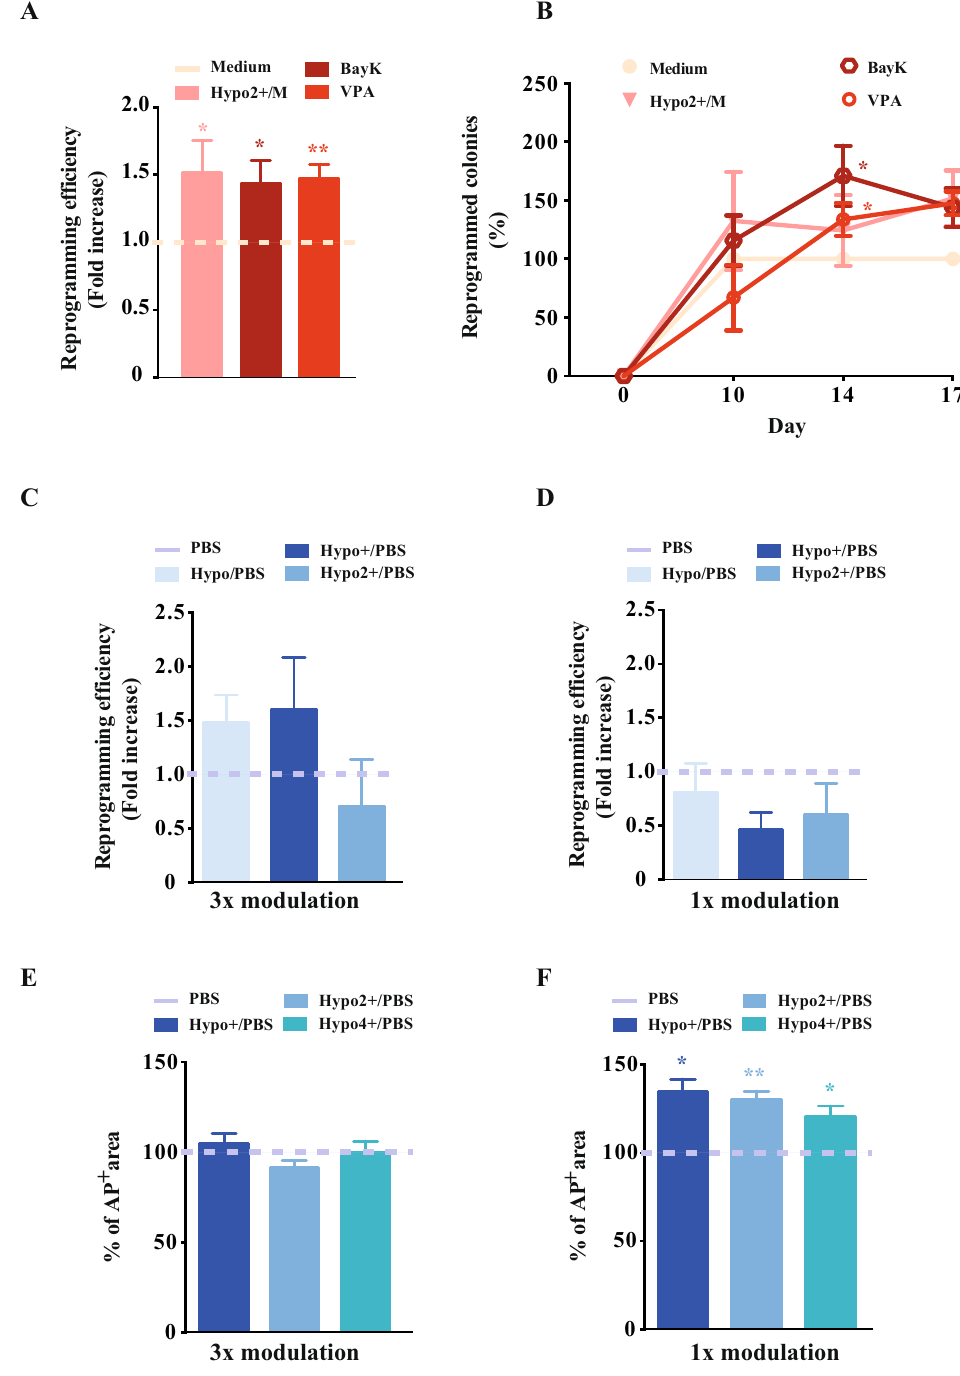
Figure 5. Effect of hyposmotic modulation in cell fate reprogramming. ( A ) and ( B ) Reprogramming efficiency and kinetics, measured as the number of alkaline phosphatase positive colonies, with different modulation protocols in UCB CD34 + CD133 + cells (normalised to the hESC medium condition). Two small molecules (VAP and BayK) with proven activity as reprogramming boosters were used for comparison with hyposmotic condition. Valproic Acid (VPA), is a chromatin modulating small molecule and BayK is a calcium agonist. ( C ) and ( D ) Fold increase in reprogramming with different hyposmotic modulation protocols in UCB CD34 + CD133 + cells (normalised to the PBS condition). ( E ), ( F ) Percentage of alkaline phosphatase positive cell culture area with different hyposmotic modulation reprogramming protocols in NDHF (normalised to the PBS condition). The different osmotic modulation protocols are described in the legend of each graph. The variations presented are the mean value ± SEM (n ≥ 3) and the changes are statistically significant at the time points highlighted in the graphs ( * p value < 0.05; ** p value <